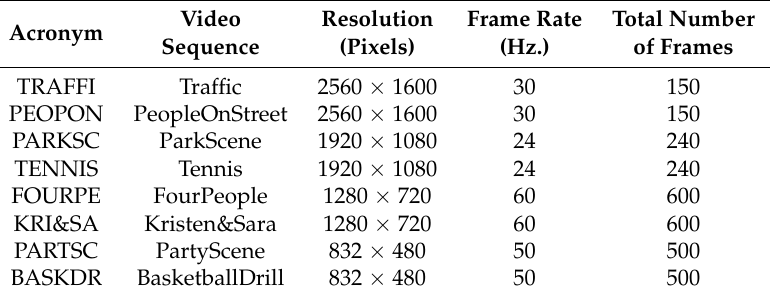
Table 3. Test video sequences.